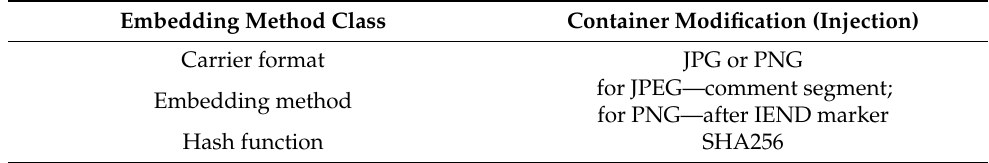
Table 1. Recommended setup for general